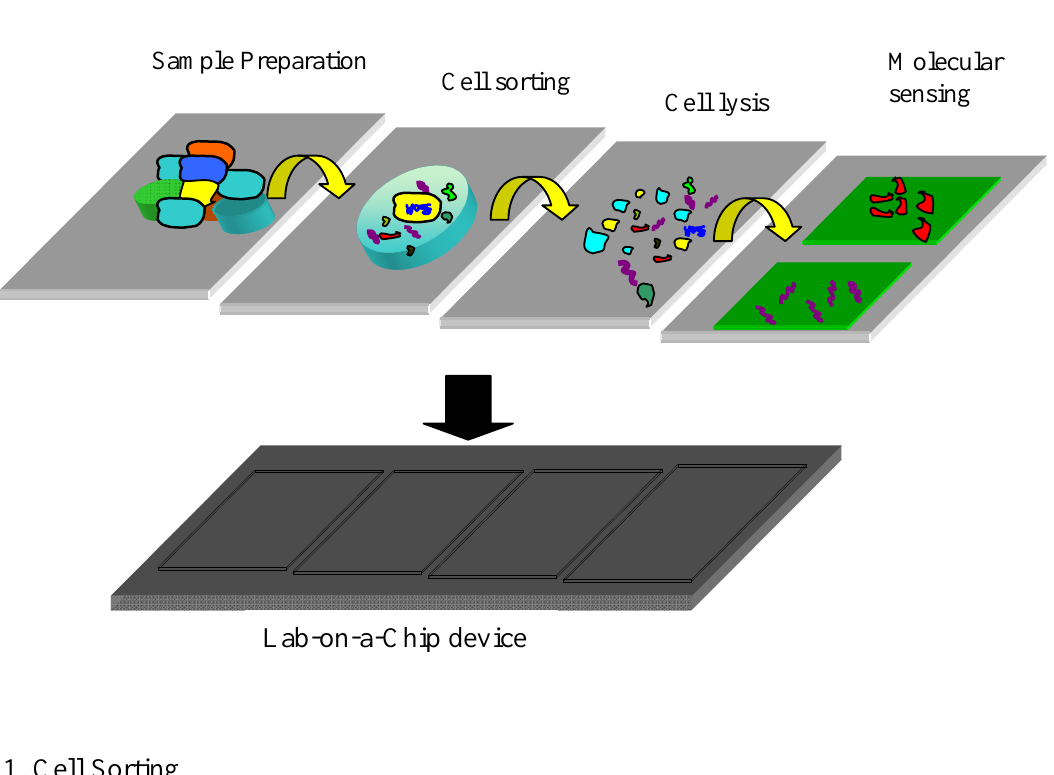
Figure 3. Graphical version for a Lab on a chip device for molecular diagnostics with representation of some of the processes stages. In the sample preparation stage, a specific type of cell is isolated from a cell population. Depending on the type of analyte molecule, a particular lysing mechanism is chosen to break down the cell membrane and the intra cellular materials of interest are released for analysis. If required, an analyte purification stage is also incorporated. In the sensing stage, the analyte molecules are detected and